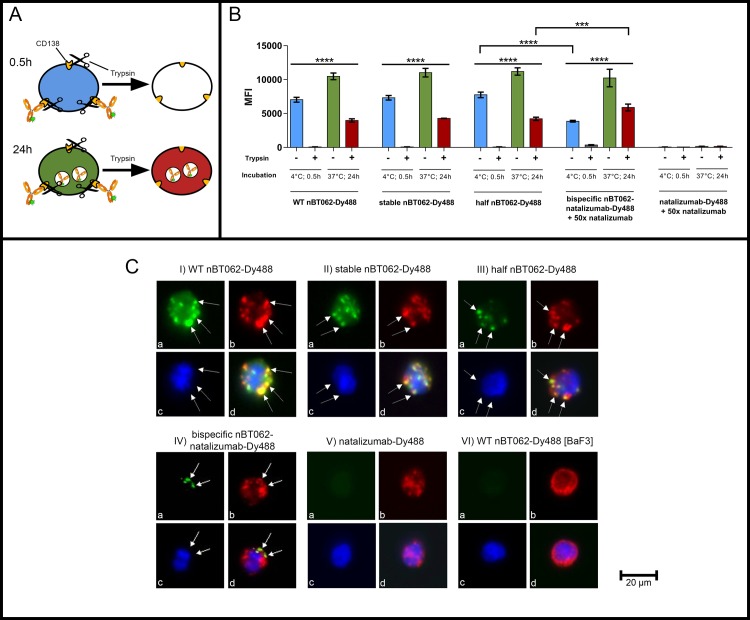
All nBT062 model variants are internalized in vitro.(A) Schematic overview of measured binding/internalization status of fluorescent labeled antibodies. (B) Flow cytometric internalization analysis of WT nBT062, stable nBT062, half nBT062 and bispecific nBT062-natalizumab. CD49d was blocked by 50x excess of unlabeled natalizumab. Data represent median fluorescence intensity values of at least three separate experiments. Column colors represent antibody location as shown in (A). ****p<0.0001, ***p<0.001. (C) Fluorescence microscopy of BaF3-hCD138 (CD138+) cells (I-V) or BaF3 (CD138-) control cells (VI) incubated for 3h with indicated Dylight-448 labeled nBT062 model antibodies or natalizumab (green, a). Lysosomal-associated membrane protein-1 (LAMP-1) is shown in red (b), nucleus is shown in blue (c). Respective overlay pictures are demonstrated (d).